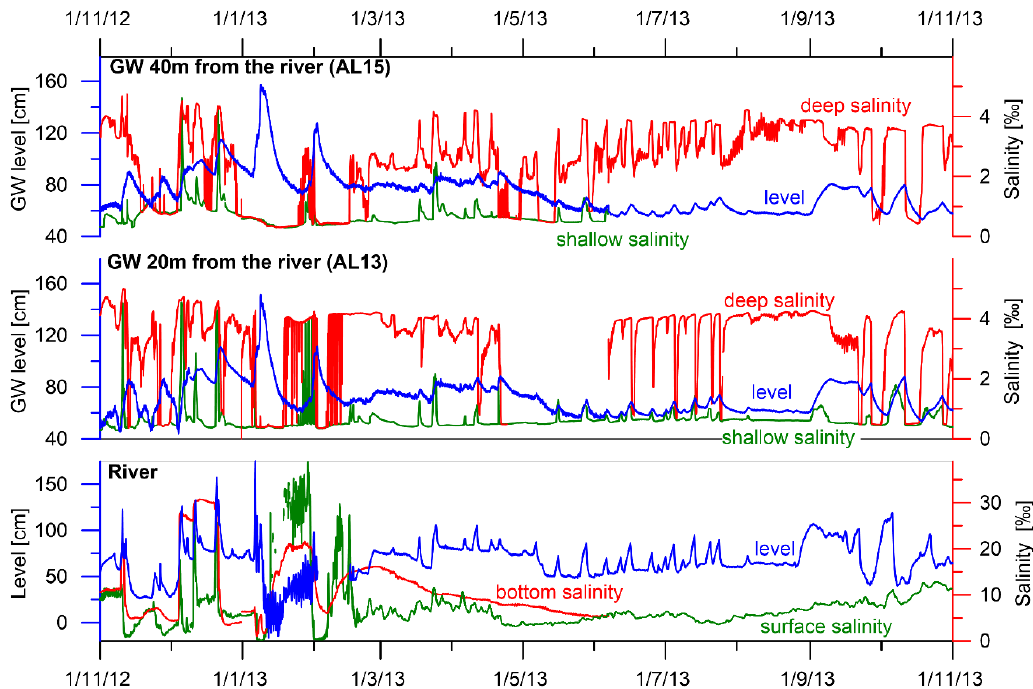
Figure 7. Groundwater level and salinity (1-h resolution) of top and bottom water at the Dune site, 40 m (top) and 20 m (center) from the river, compared with river level and salinity (surface and bottom). Groundwater salinity was measured just above and below the fresh–saline interface (FSI; ~1 m and ~3 m below groundwater level, respectively).